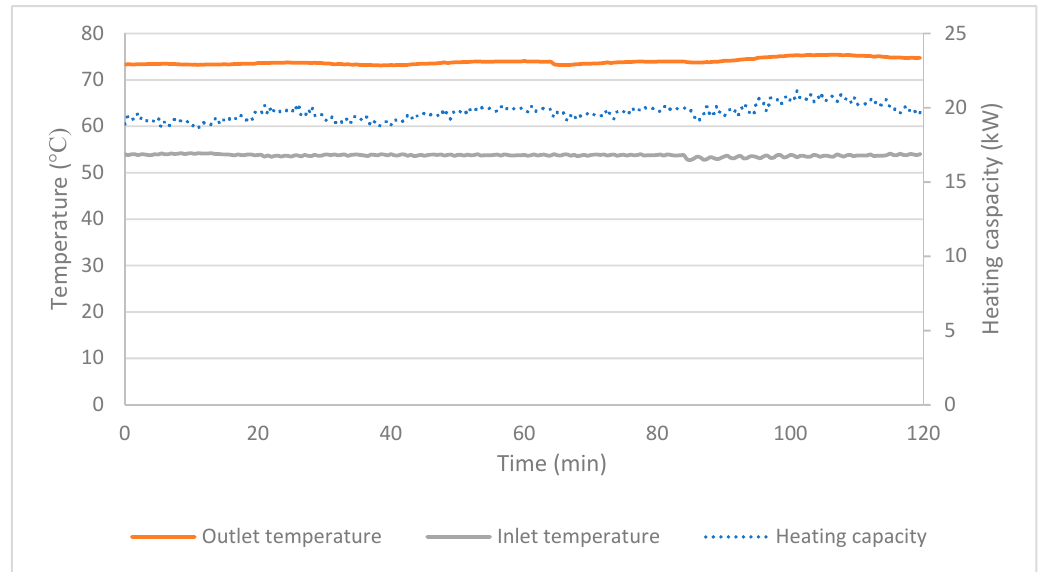
Figure 6. Heated water temperature and boiler's heating capacity during combustion of wood pellets, full load.